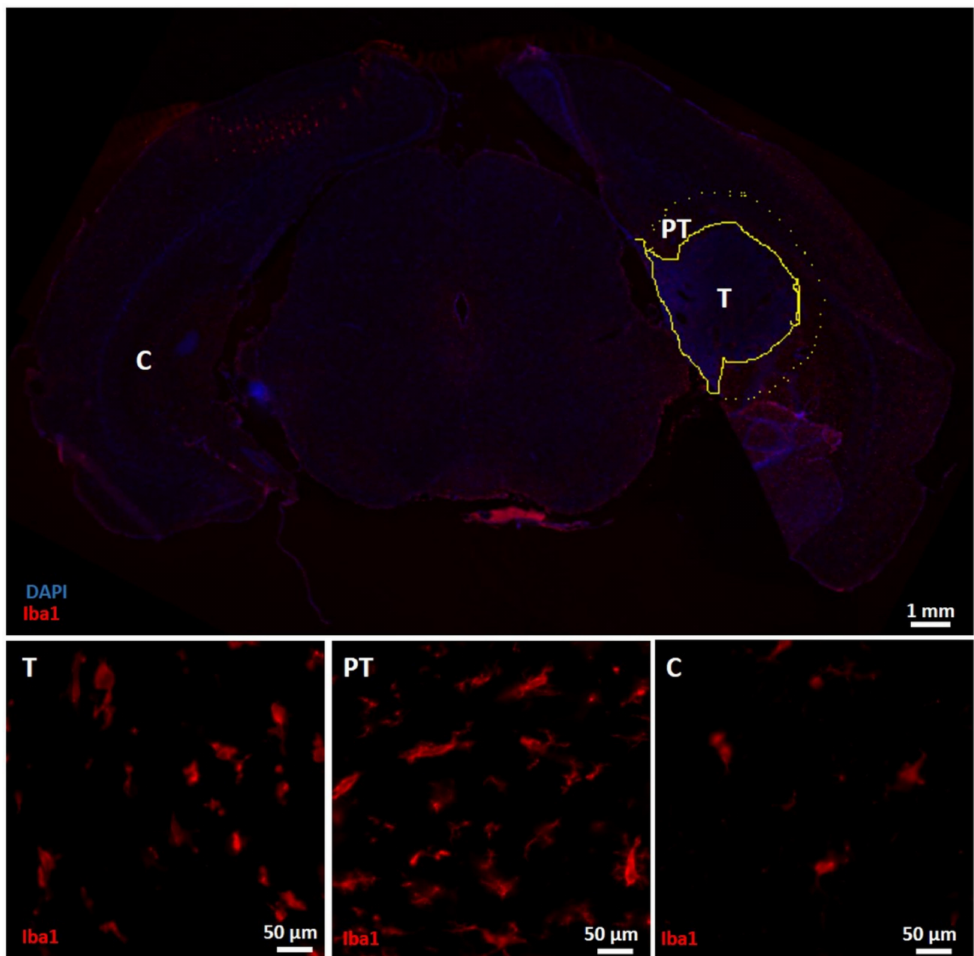
Figure 5. Immunohistochemical analysis for Iba1. The upper panel shows an overview slice with Iba1 and DAPI expression. The tumor mass (T) is delineated by a yellow line. Around the tumor mass, a peritumoral area (PT) was delineated by a yellow dashed line. The lower panel shows ROIs in the different zones. T: ROI in the tumor mass with Iba1 staining; infiltration of granular Iba1-positive cells can be observed. PT: ROI in the peritumoral region with Iba1 staining; numerous Iba1-positive cells with more processes were found around the tumor mass. C: ROI in the contralateral healthy brain tissue with Iba1 staining; Iba1-positive cells are identified, but less present compared to the tumor mass and especially the peritumoral region. T—tumor mass; PT—peritumoral region; C—contralateral healthy brain